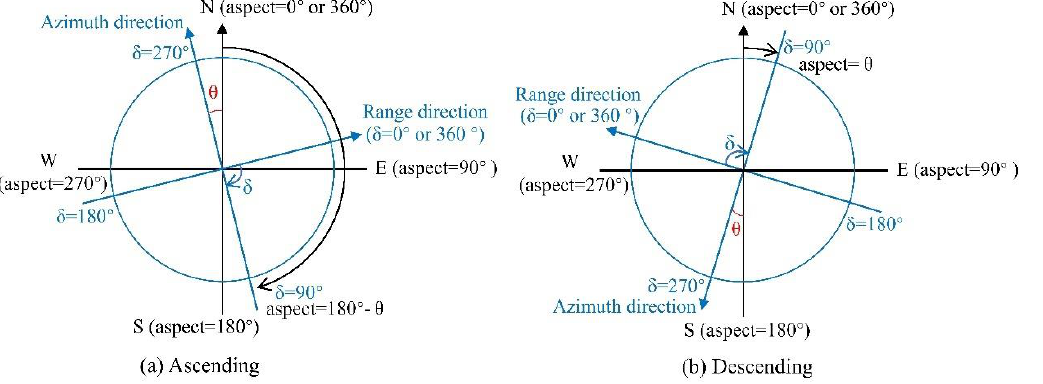
Figure 5. Spatial relationship between aspect- beam angle δ, pixel’s aspect, and radar beam direction, where θ in red is the angle between the satellite orbit and north, which is 8.18 degrees for Sentinel-1A. The straight black line and arrow represent the aspect and are described in black font. The blue line and arrow indicate the satellite azimuth and range direction, respectively. ( a , b ) correspond to the ascending and descending nodes, respectively.